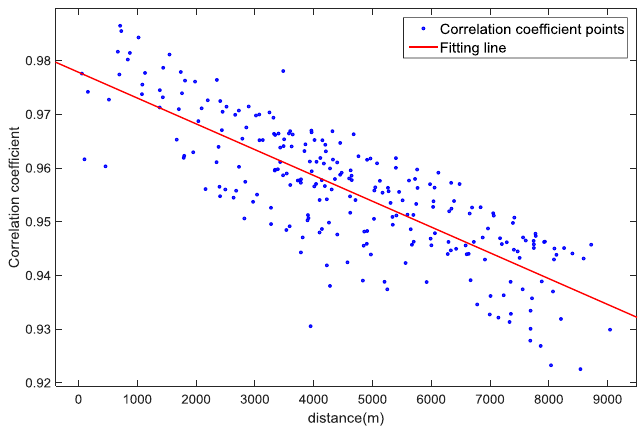
Figure 10. Correlation coefficients in different geographical distances between any two wind turbines in the Qiaodong II wind farm.